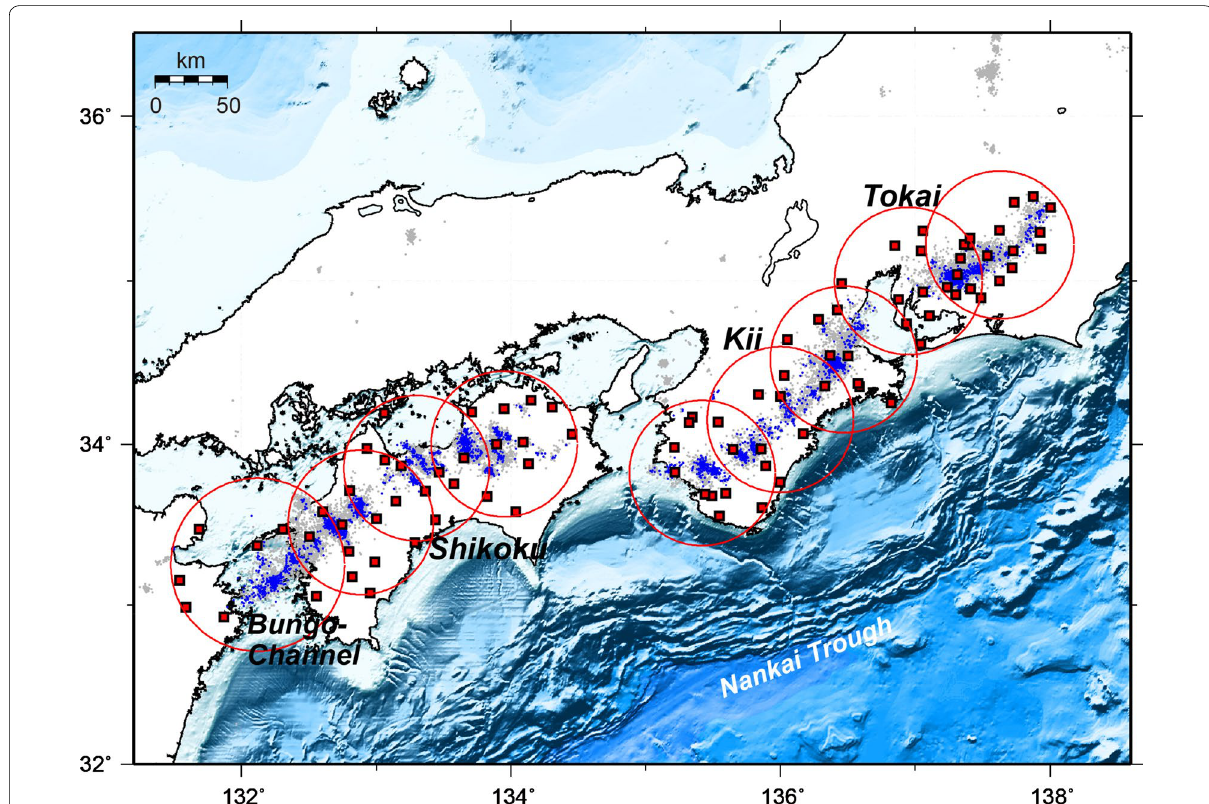
Fig. 1 Map of template LFEs and seismic stations used in the present study. Gray dots denote all LFEs determined by the JMA from 1 April 2004 through 31 August 2015. Blue dots correspond to 3500 template events used in the matched filter technique. Red squares represent permanent Hi-net and F-net seismic stations used in the analysis (NIED 2019a; NIED 2019b). Red circles show nine subregions used for matched filter